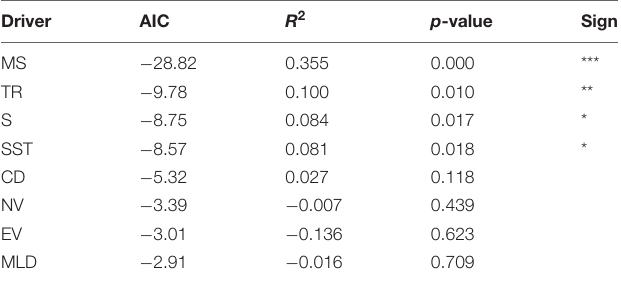
TABLE 2 | The effects of different variables on the economic value of small yellow